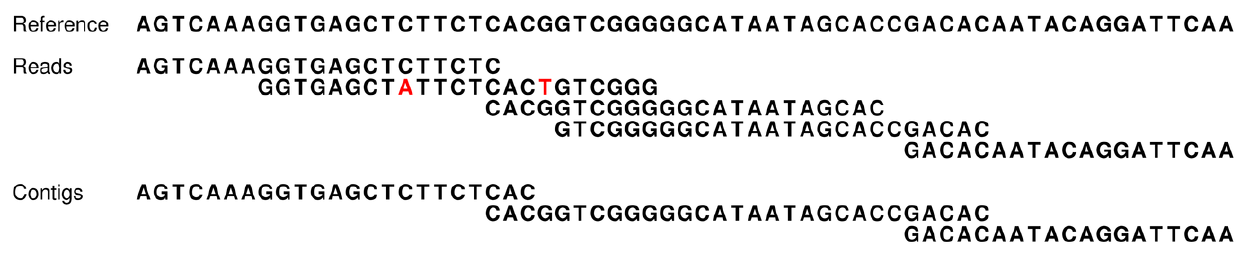
Figure 5. How word size can influence the performance of a De Bruijn graph